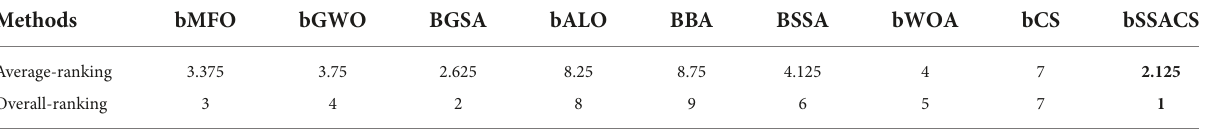
TABLE 10 The ranking of bSSACS-KELM and its peer